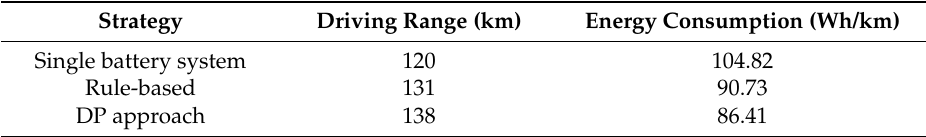
Table 6. Comparison of driving range and energy consumption under NEDC